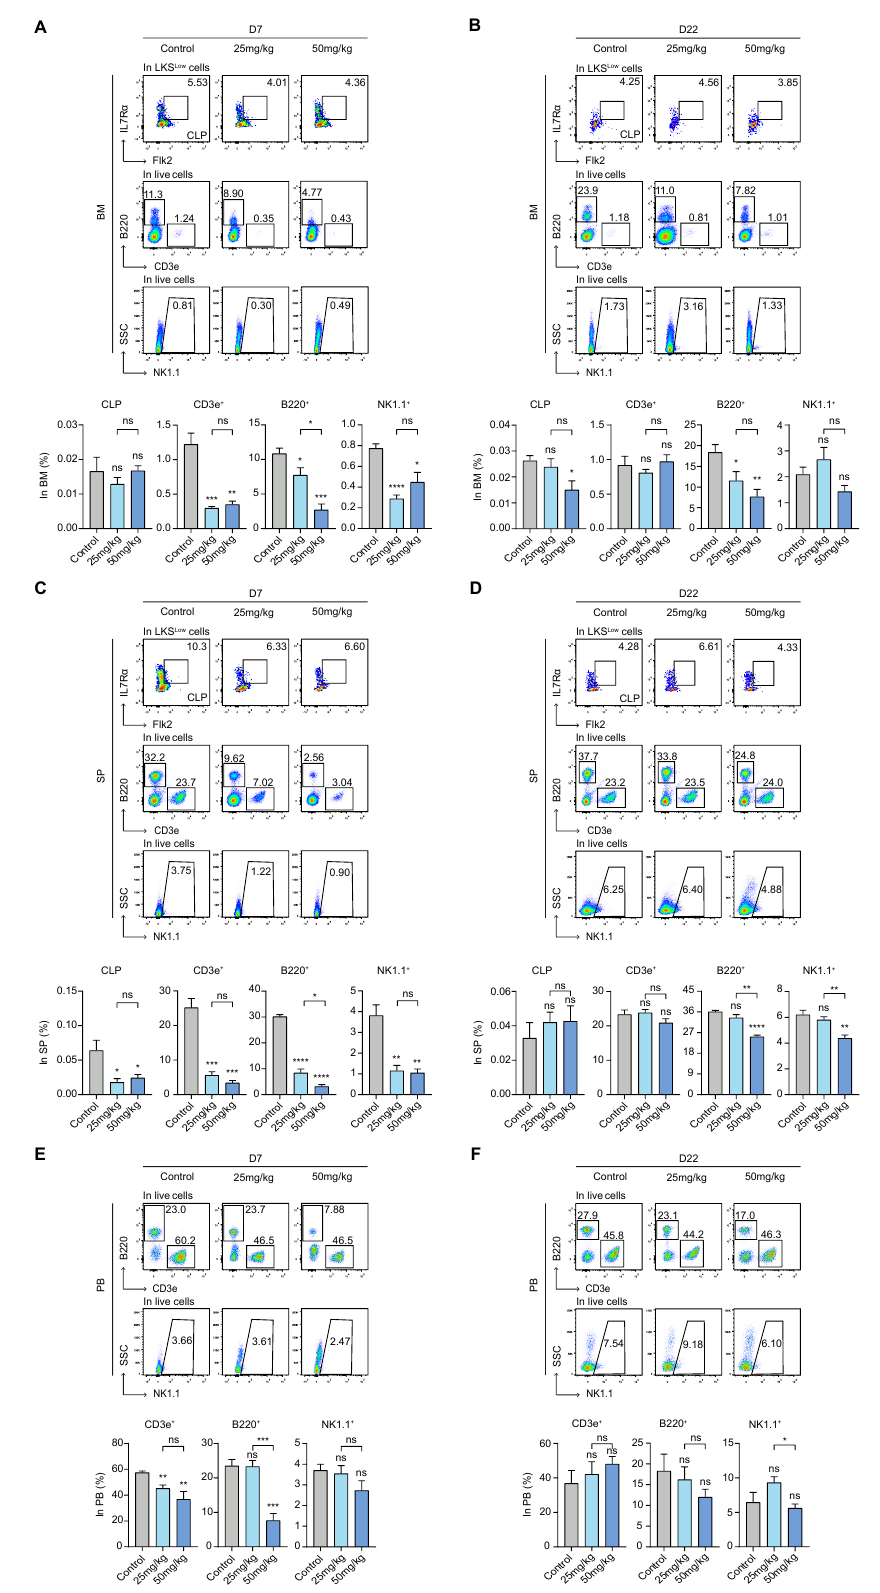
Figure 6. Effect of S63845 treatment on lymphoid differentiation in CB6F1 mice. ( A ) Representative FACS profiles and percentages of CLP, CD3e + , B220 + , and NK1.1 + subpopulations in BM cells of control and S63845-treated mice on day 7. Control, n = 5; 25 mg/kg, n = 5; 50 mg/kg, n = 4. ( B )